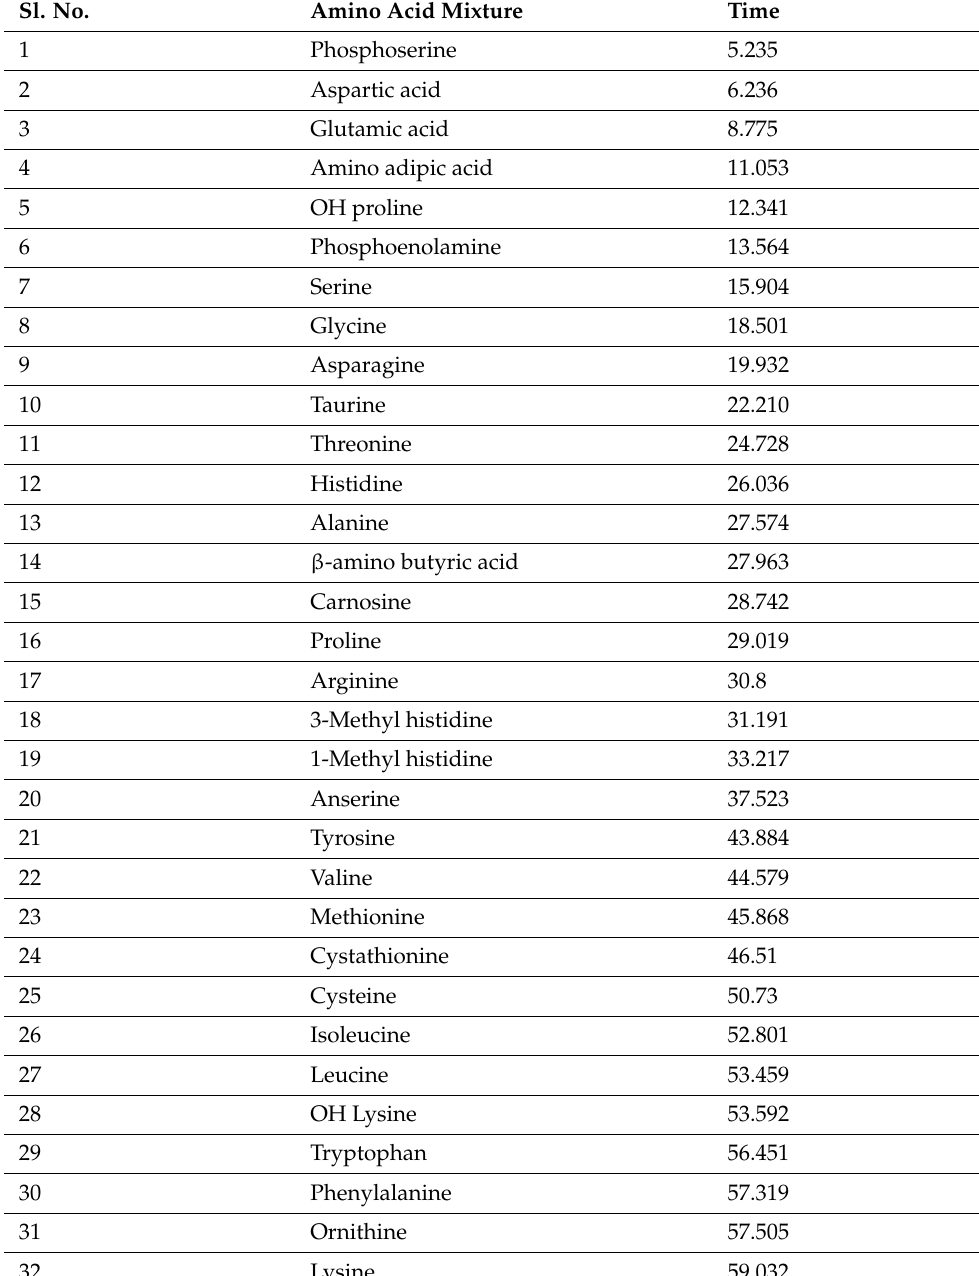
Table 1. HPLC standard values of total amino acids (TAAs) for the estimation of the TAA content present in the isolated